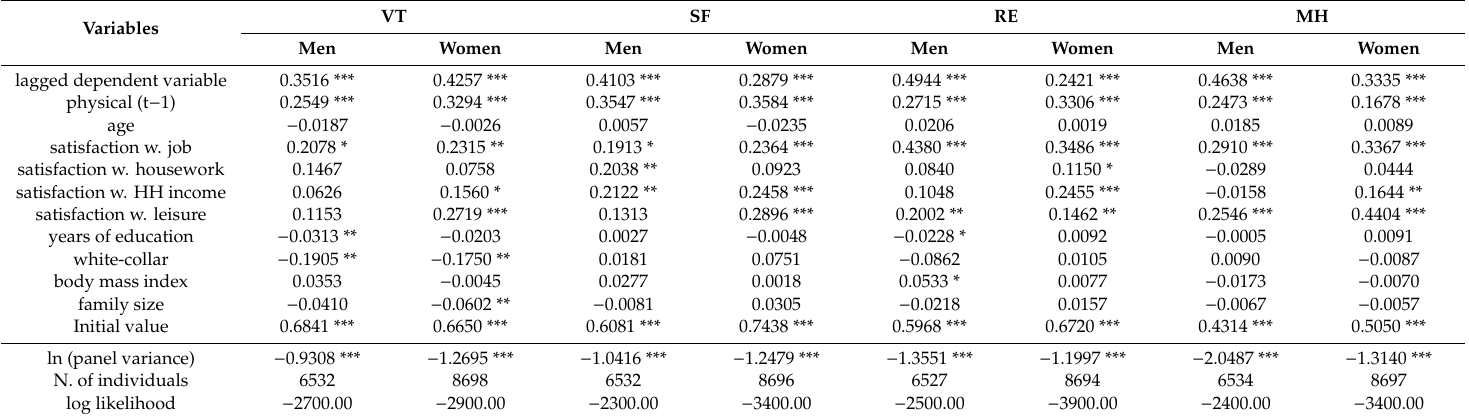
Table 6. Estimation results: coe ffi cient estimates of mental-related submeasures.